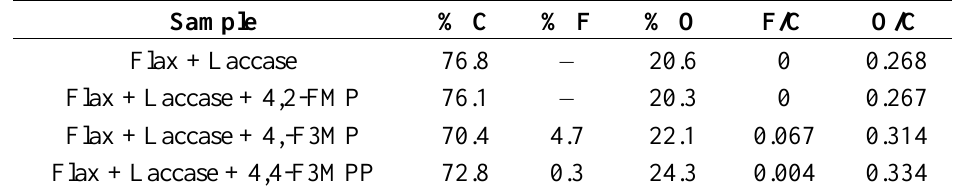
Table 2. XPS analysis of flax fibers after laccase treatment with different